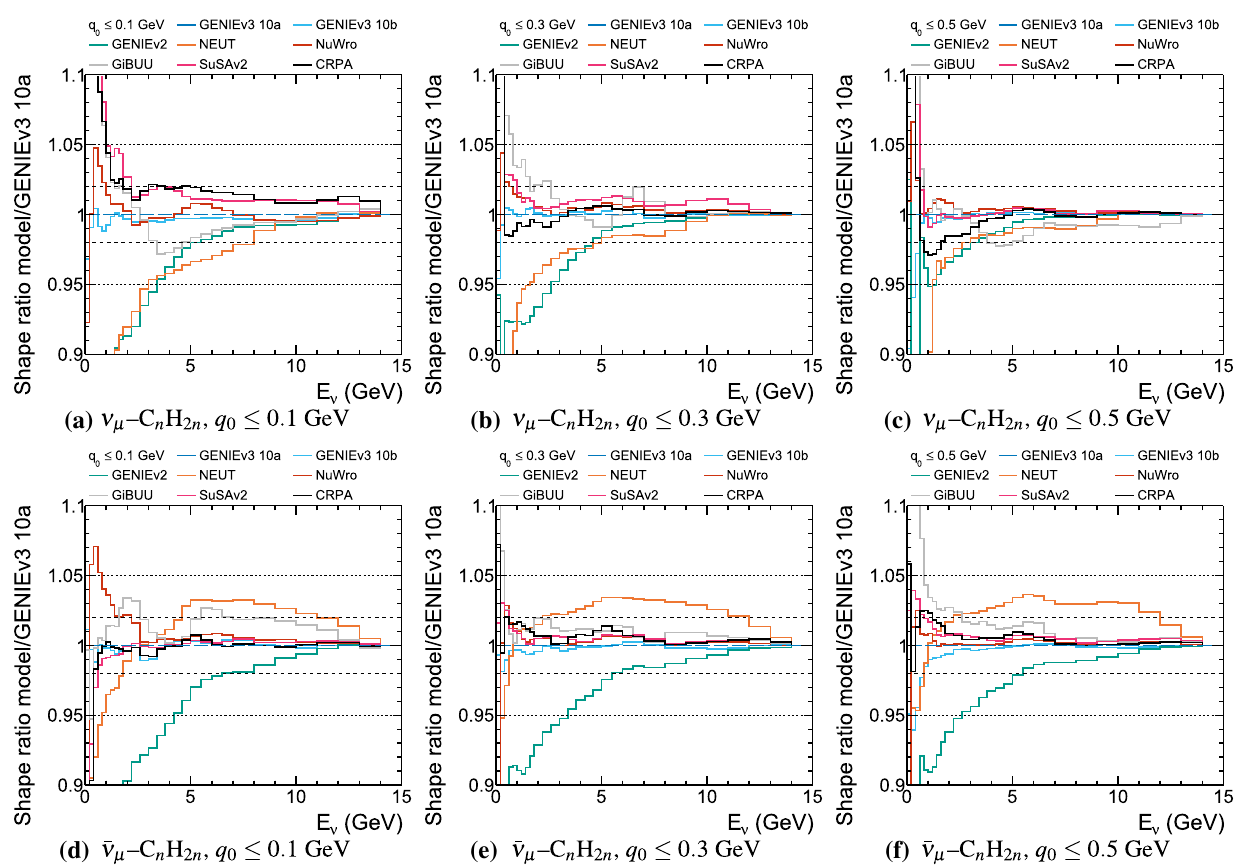
Fig. 13 Comparison of the shape-only ratios of the charged-current cross section with q 0 ≤ 0.1, 0.3 and 0.5 GeV as a function of E true ν , with respect to the GENIEv3 10a prediction. Shown for both ν μ –C n H 2